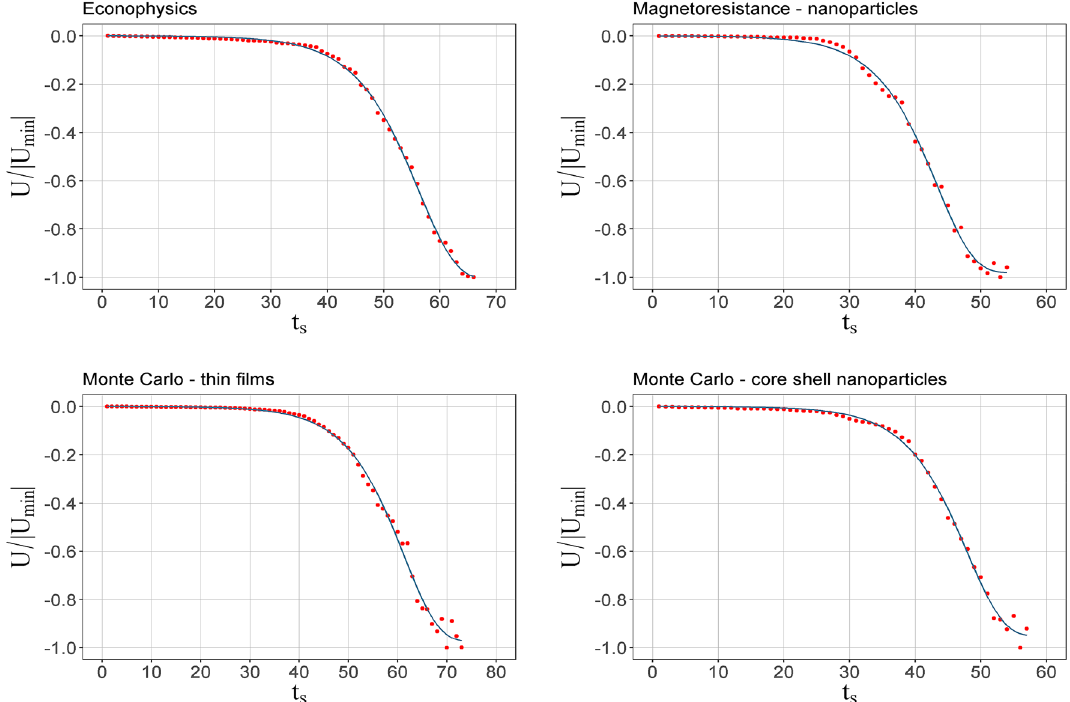
Figure 3. Normalized energy as a function of time for the co-authorship networks. The blue line is an adjustment to get the inflection point.